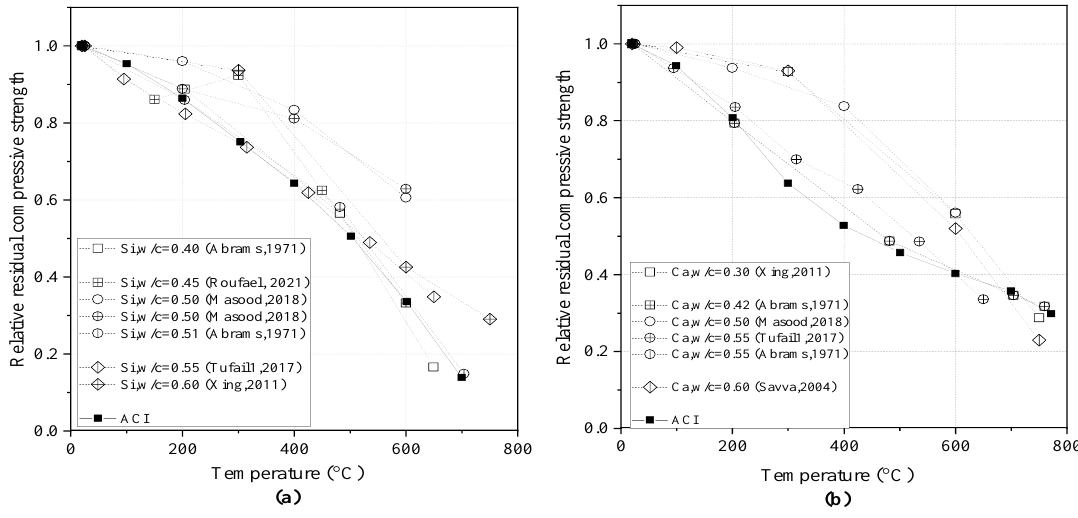
Figure 12. The relative residual compressive strength: ( a ) siliceous (Si)-aggregate concrete, ( b ) calcareous (Ca)-aggregate concrete [71 – 74,78,81].